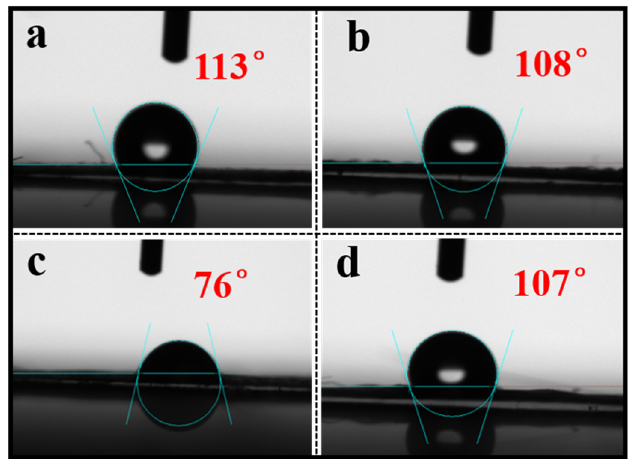
Figure 5. The contact angle photos of various paper relics: before ( a ) and after ( b ) restoration of the newspaper; before ( c ) and after ( d ) restoration of the books.